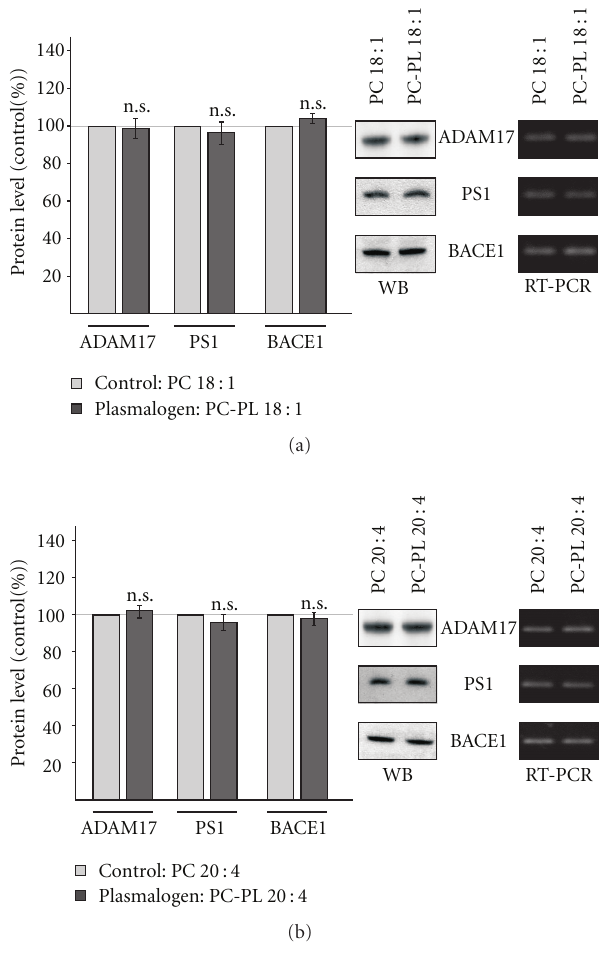
Figure 2: Protein level of the secretases involved in APP processing. (a) SH-SY5Y cells were incubated with PC-PL 18: 1 and the corresponding phospholipid PC 18: 1. Cell lysates were prepared, subjected to gel electrophoresis and Western blot (WB) analysis. Protein level of ADAM17, PS1, and BACE1 were detected with antibodies ab39162, sc-7860 and B0806, respectively. (b) E ff ect of PC-PL 20: 4 on protein level of ADAM17, PS1, and BACE1 compared to the corresponding phospholipid PC 20:4. Detection was performed as described for (a). All quantified data represent an average of at least three independent experiments. Error bars rep- resent standard deviation of the mean. Asterisks show the statistical significance ( ∗ P ≤ 0 . 05; ∗∗ P ≤ 0 . 01 and ∗∗∗ P ≤ 0 . 001, n.s. = not significant).(a, b) Representative WBsof protein determination and representative agarose gels of RT-PCR analyis are shown.